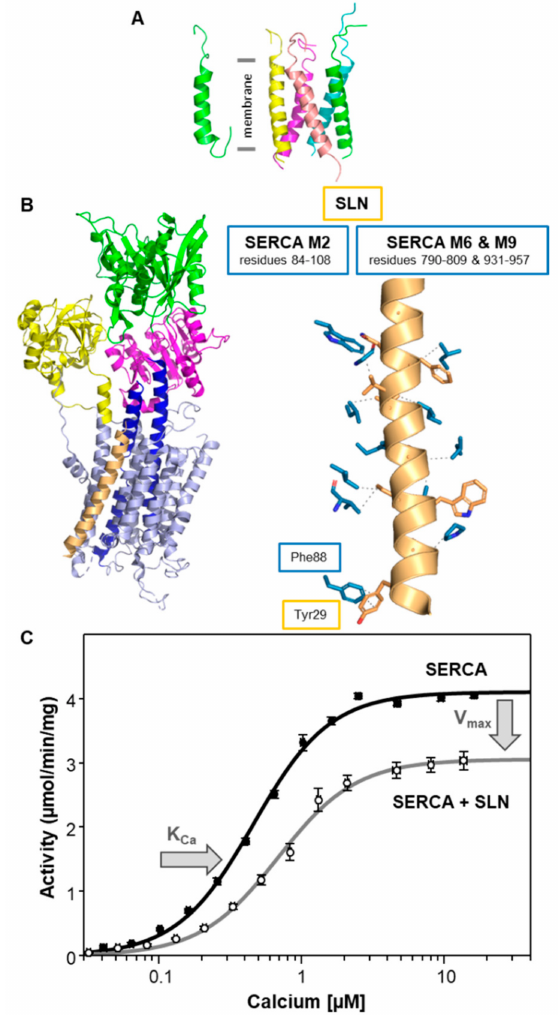
Figure 3. SERCA and sarcolipin (SLN). ( A ) Molecular model of the SLN monomer (PDB code 1JDM) and pentamer [58]. The transmembrane domain is indicated. ( B ) Molecular model of the SERCA- SLN complex (PDB codes 3W5A and 4H1W). SLN is colored tan. SERCA is colored light blue with the actuator domain in yellow, the phosphorylation domain in magenta, the nucleotide-binding domain in green, and transmembrane segments M4 and M5 in blue. Also shown are the side-chain interactions between SERCA (blue) and SLN (tan). The relative locations of SERCA transmembrane segments M2, M6, and M9 are indicated. An interaction involving Tyr 29 of SLN and Phe 88 of SERCA is shown. For the full list of interactions, refer to Table S2. ( C ) Calcium-dependent ATPase activity of SERCA reconstituted into membrane vesicles in the absence (black) and presence of SLN (gray). The changes in the apparent calcium affinity (K Ca ) and maximal activity (V max ) of SERCA are indicated by arrows. Each data point is the mean ± standard error ( n ≥